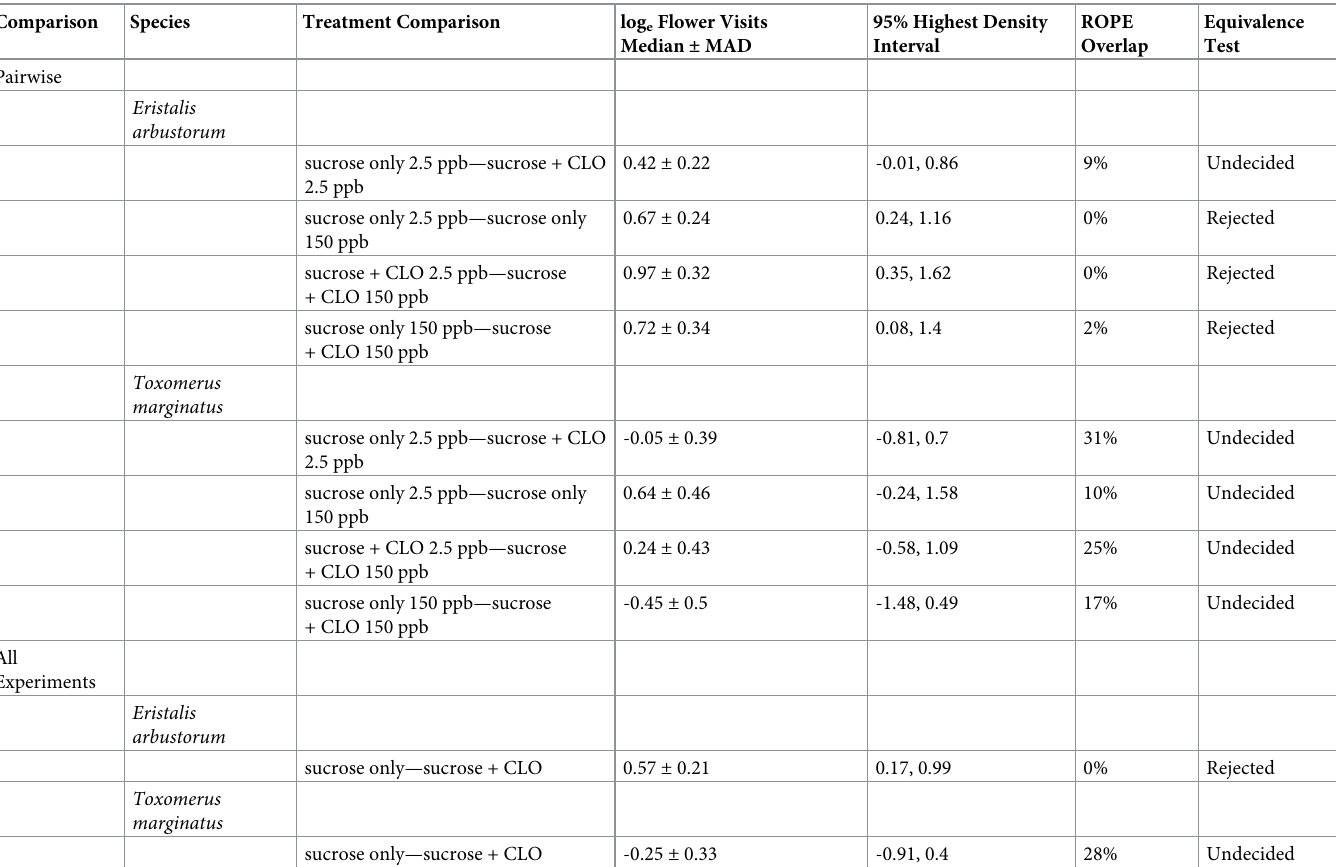
“Pairwise” comparison is sucrose only vs. sucrose + CLO (clothianidin), 2.5 ppb or 150 ppb. “All experiments” comparison: sucrose only vs. sucrose + CLO